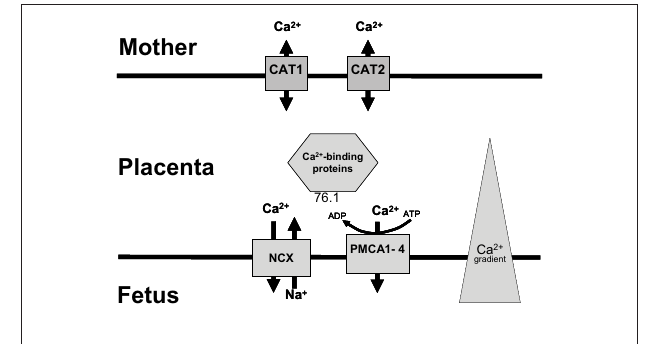
FigurE 1 | Placental calcium transport: Calcium enters from the maternal circulation via facilitated transporters (CAT 1 and 2), crosses the cytosol bound to proteins such as calbindin and is then actively extruded into the fetal circulation by Na/Ca exchanger and PMCA proteins (plasma membrane calcium ATPases). Used with permission (Williams et al.,